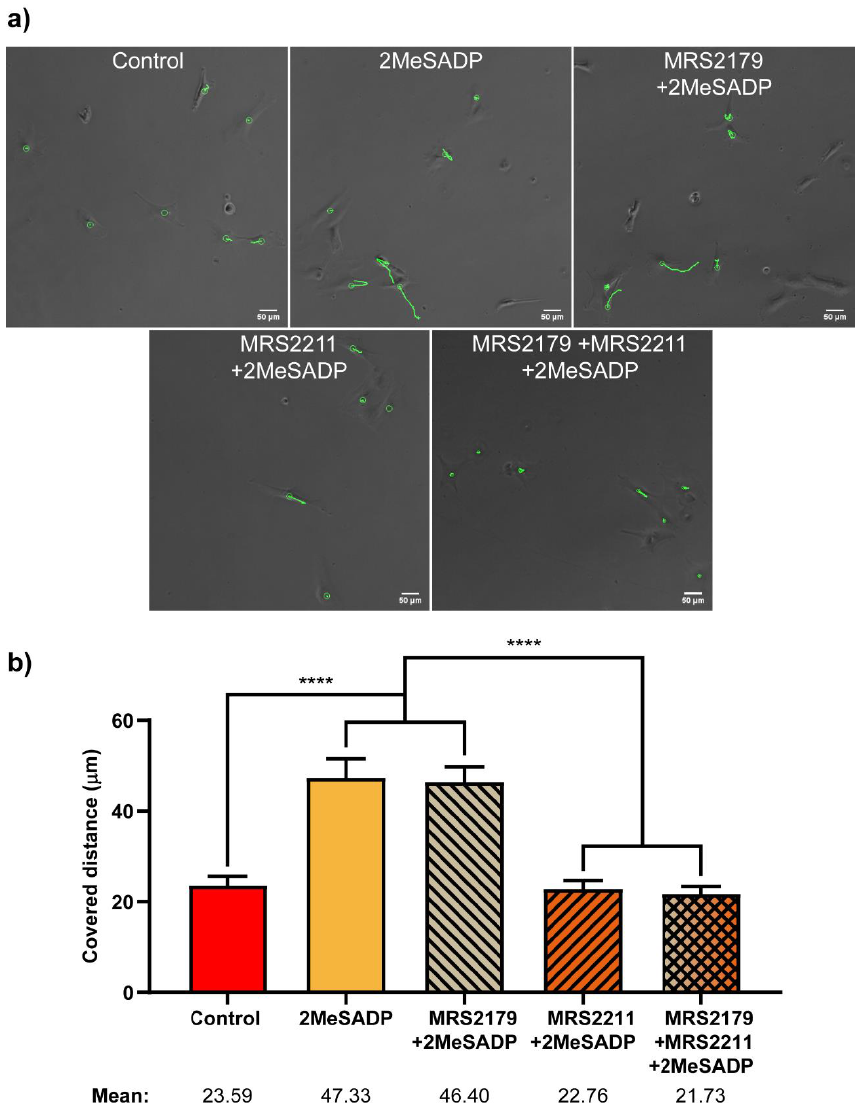
Figure 7. Effects of 2MeSADP treatment and P2Y 1 and P2Y 13 antagonism on migratory capabilities of rat cerebellar astrocytes. ( a ) Bright field images of astrocytes obtained after three hours of Time-Lapse video microscopy. Green circles indicate different tracked cells. Green lines show the location of the cell during the three hours. ( b ) Columns show the total distance covered by the cells, in microns, during a period of three hours, in basal conditions or after incubation with 2MeSADP for one hour, in the presence or absence of antagonists MRS2211 and MRS2179, and a combination of both. Whiskers indicate S.E.M., statistically significant differences are indicated by **** when p < 0.0001.